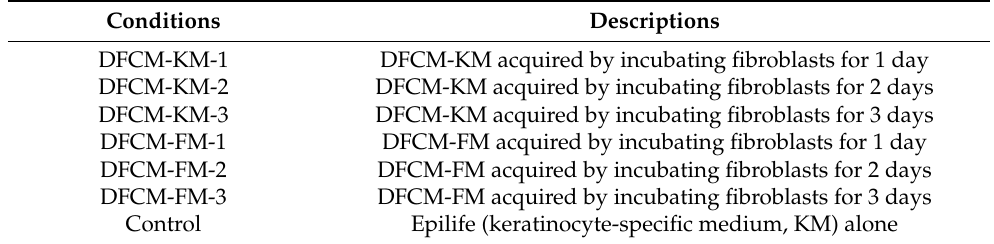
Table 2. Culture conditions for keratinocytes supplemented with